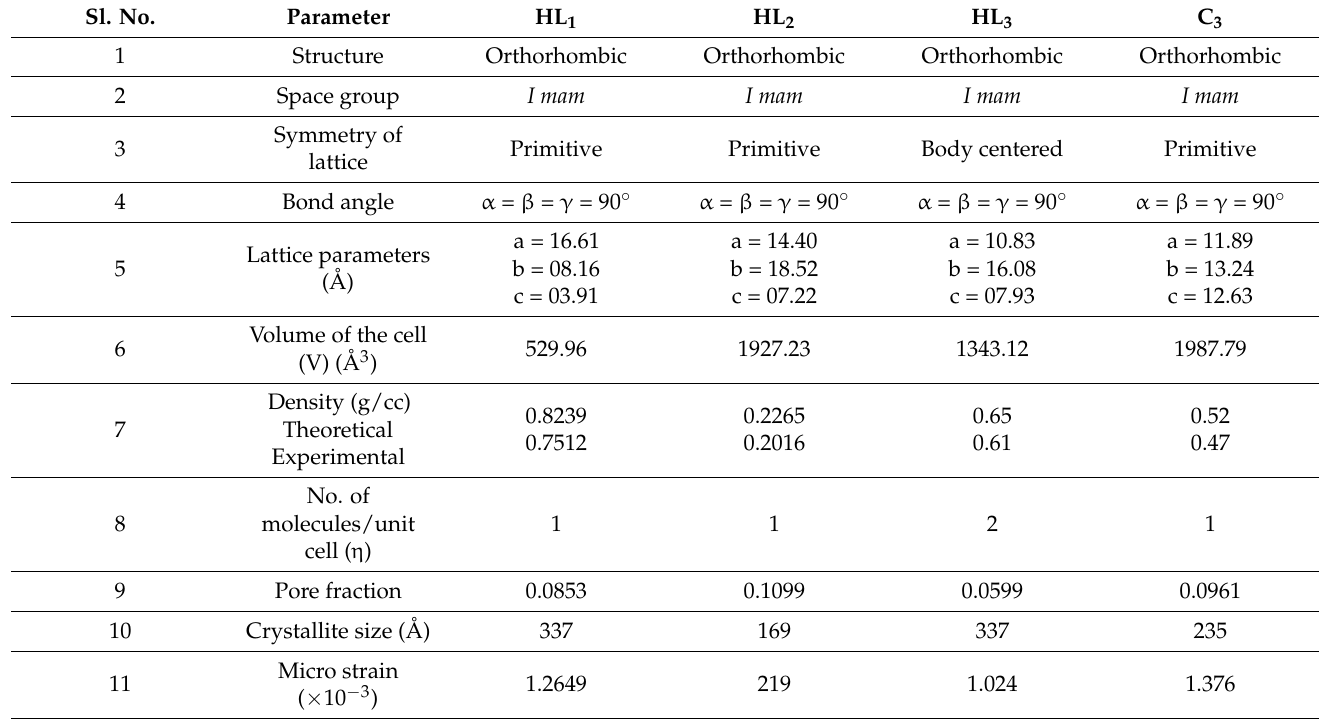
Table 5. X-ray parameters of HL 1 , HL 2 , HL 3 and C 3